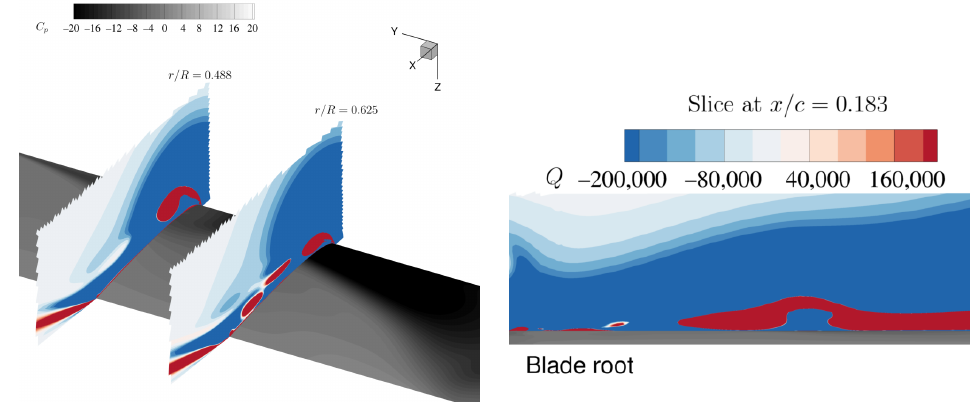
Figure 11. The swell structure on the blade, represented with x and y slices. Left : slices at r / R = 0.488 and 0.625; Right : slice at x / c =